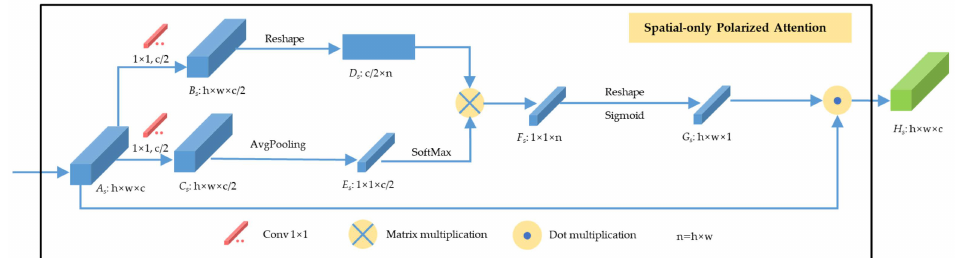
Figure 5. Details of the spatial-only polarized attention mechanism in our network.